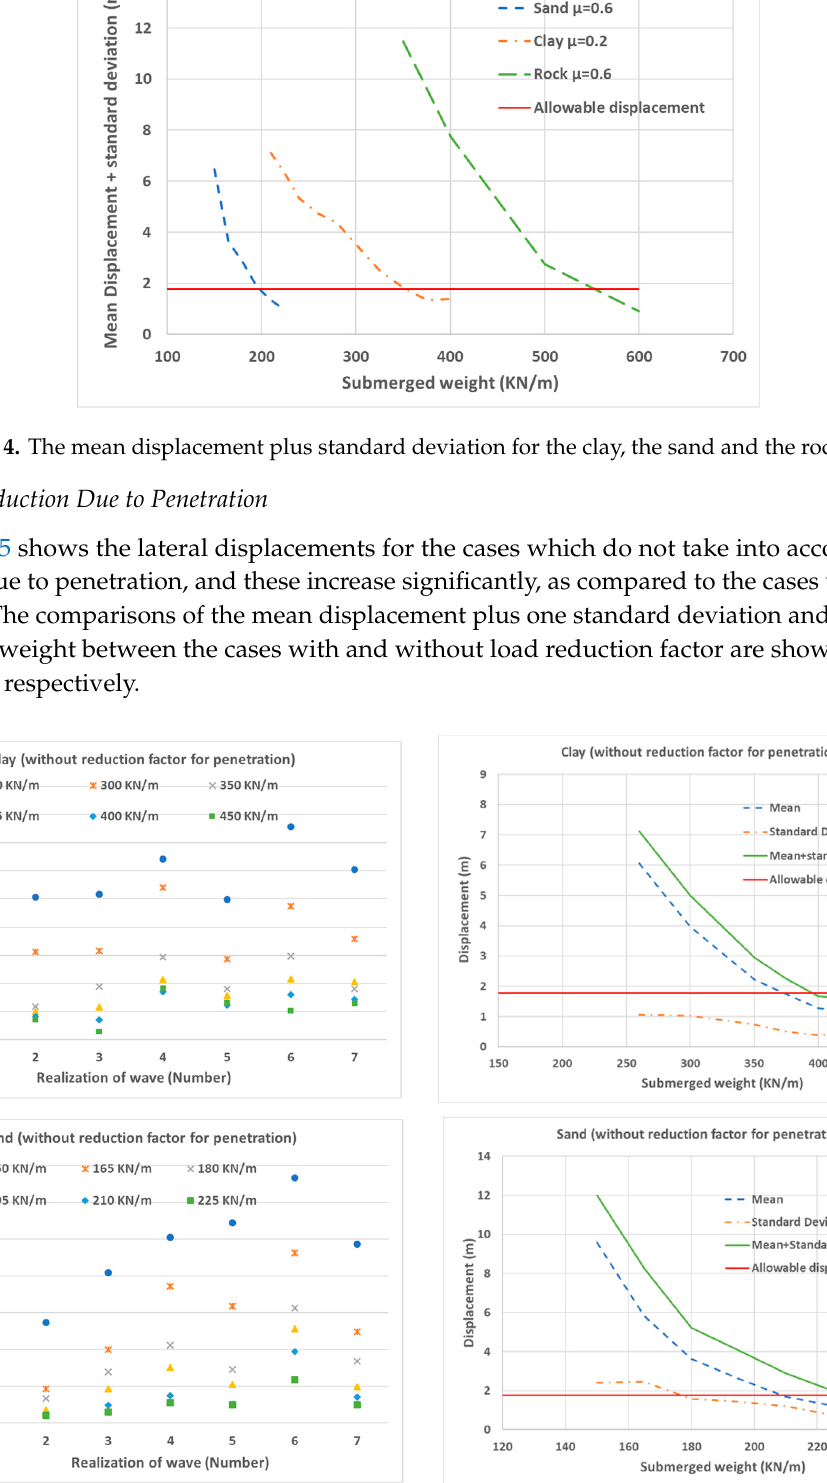
Figure 4. The mean displacement plus standard deviation for the clay, the sand and the rock cases. Table 8. The required submerged weight.